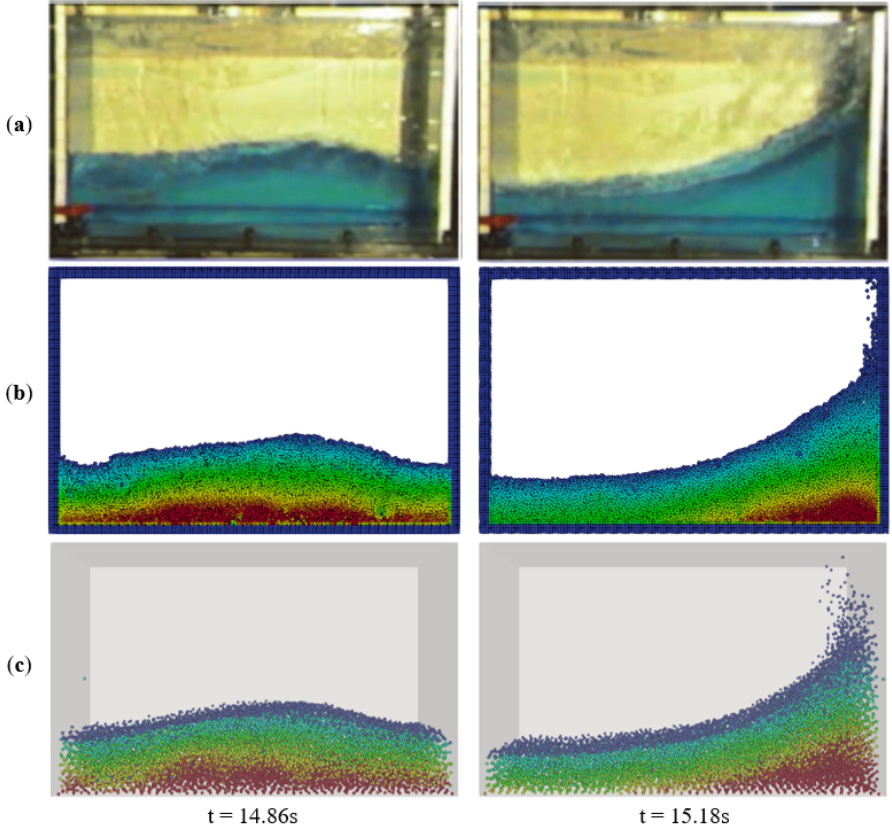
Figure 3. Comparisons of free surface profiles results. ( a ) experimental results given by [60]; ( b ) 2D numerical simulation results obtained in this paper; ( c ) 3D numerical simulation results obtained in this